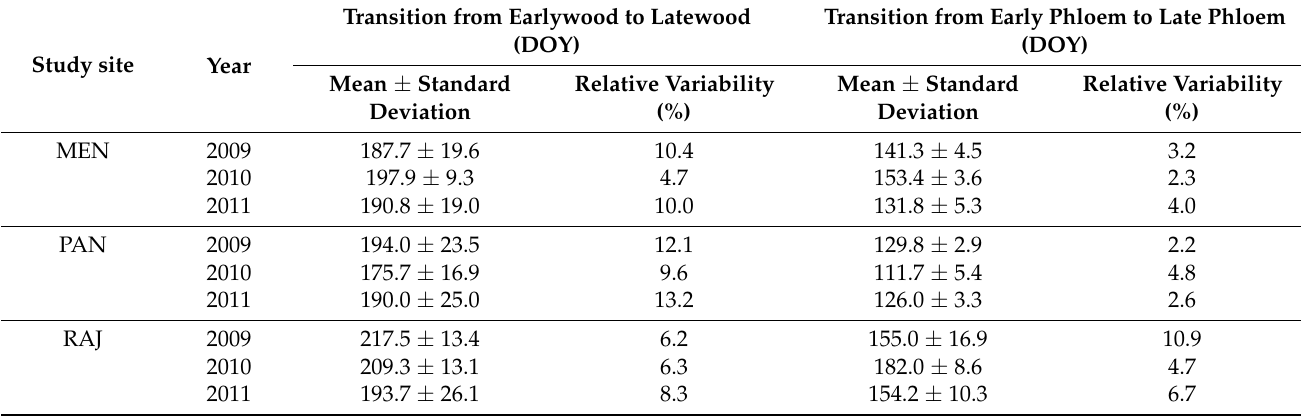
Table 2. Days of transition from earlywood to latewood and early phloem to late phloem for Norway spruce at MEN, PAN, and RAJ in 2009–2011. DOY—day of the year.